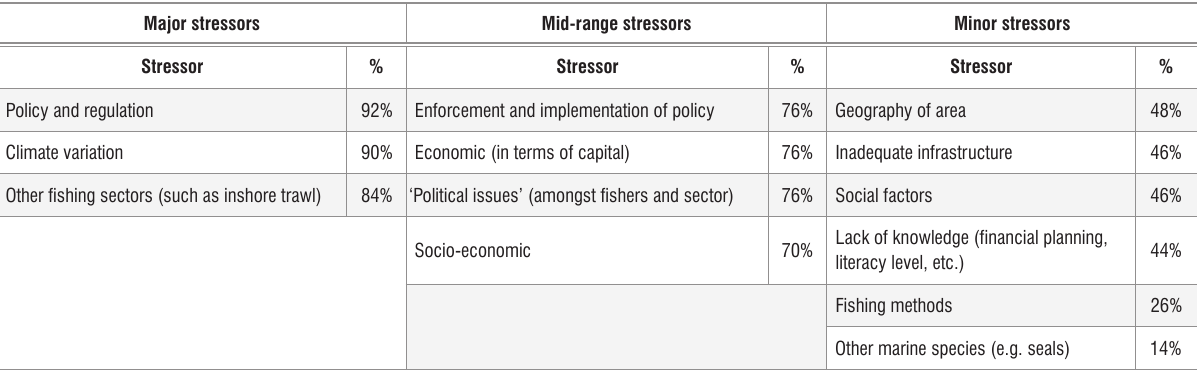
Table 2: Stressors identified by participants. Stressors identified by 80% or more of all participants were termed ‘major’, those identified by 50–79% ‘mid-range’ and by less than half of the participants as ‘minor’. Major stressors Mid-range stressors